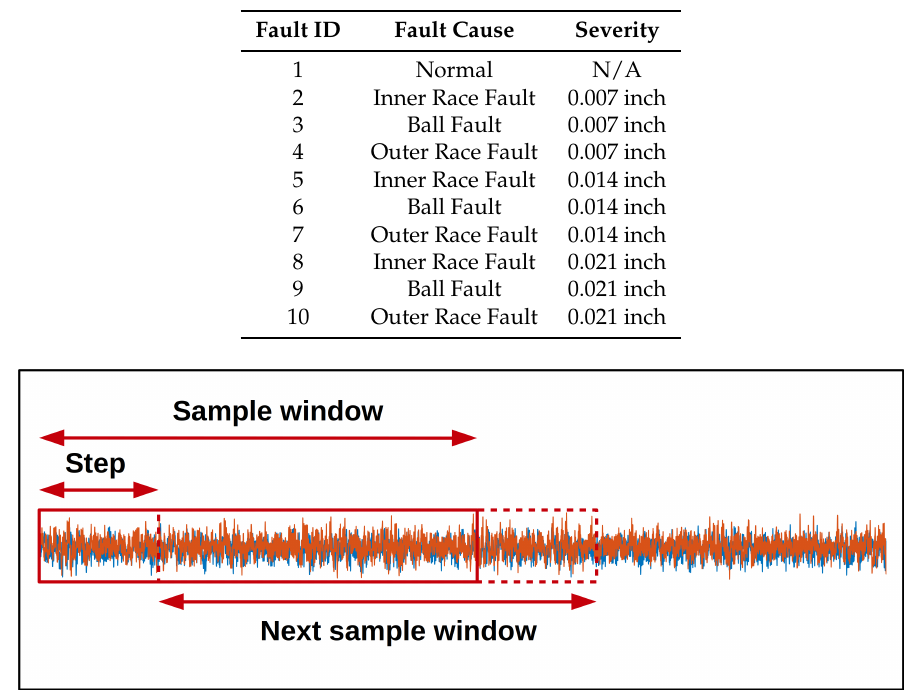
Table 2. Bearing fault descriptions for the Case Western Reserve University (CWRU) dataset.